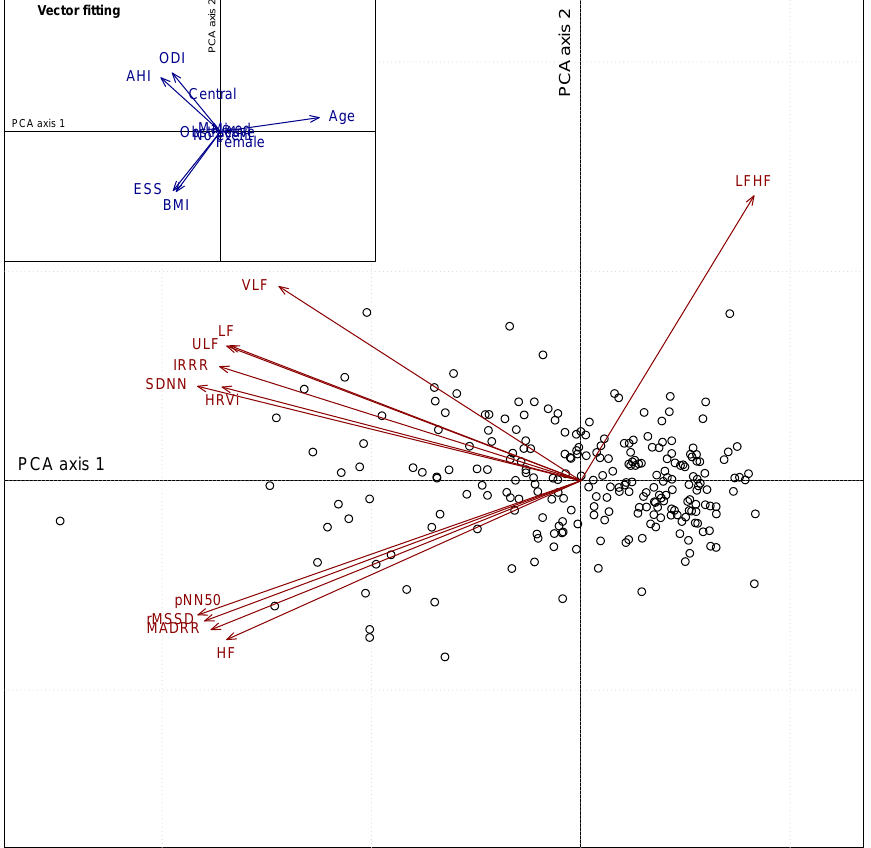
Figure 1. PCA biplot representation of the HRV features (red arrows) and patient information (empty circles) derived from filtered ECG belt data. External explanatory variables including patient baseline characteristics were fitted to the PCA for interpretation purposes and represented by blue arrows oriented towards the direction of maximum correlation (inset on the upper left